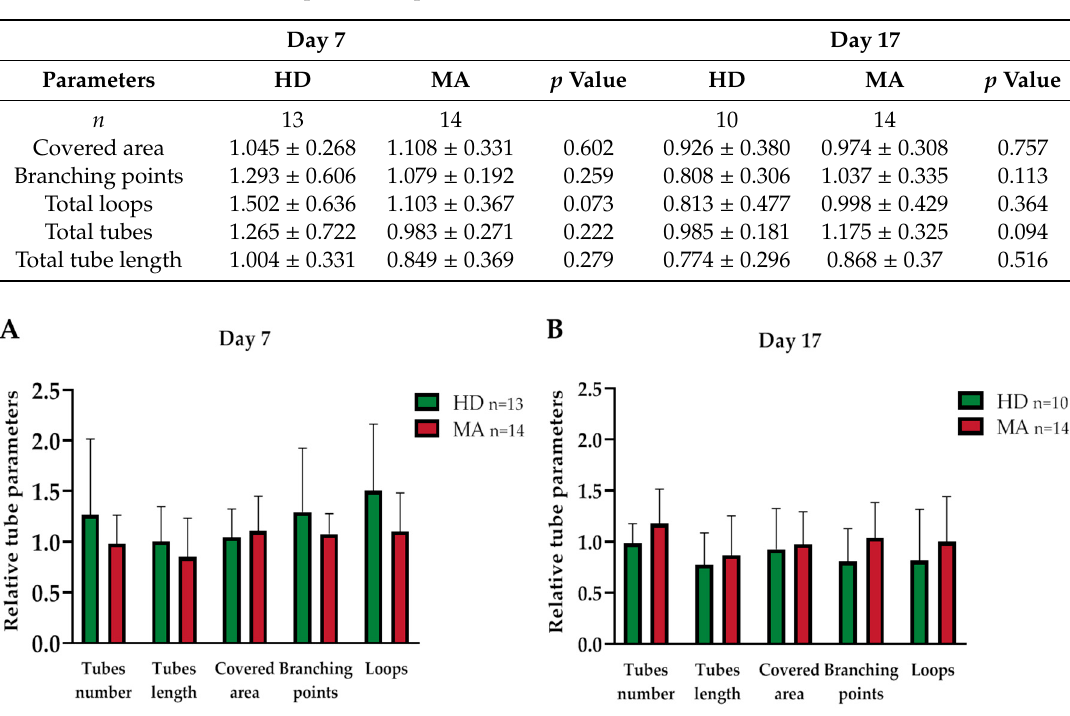
Table 3. Normalized values for % of covered area, number of branching points, total number of loops, total tube number, and total tube lengths in the tube formation assay, performed with conditioned media collected at days 7 and 17 after seeding of EPCs of HD and of a homogeneous group of MA patients: Data were expressed as mean ± SD, and statistical significance was calculated through Student’s t -test. Values of at least three independent experiments are shown.